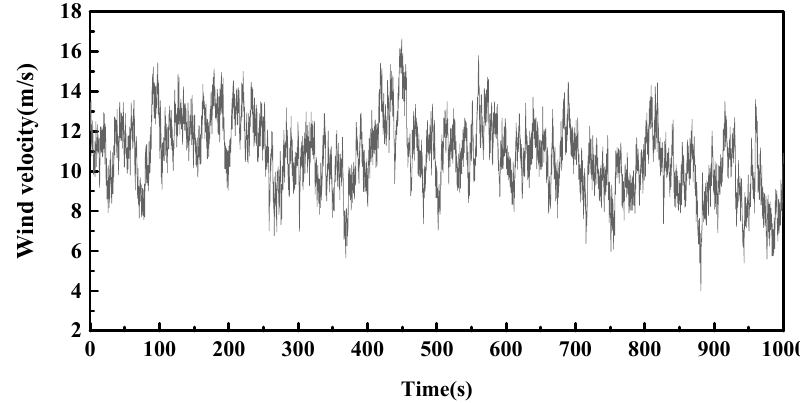
Figure 5. Time series of wind velocity.